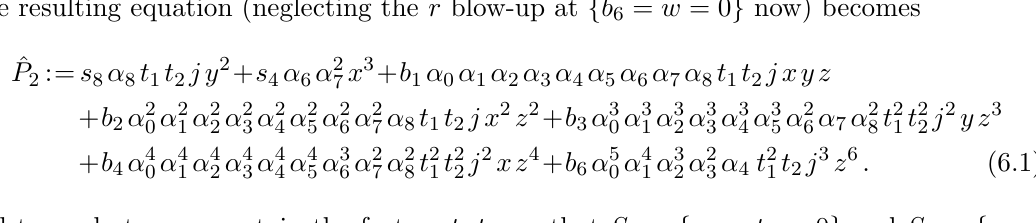
Figure 5 . The facet of the E over f s 4 g \ W